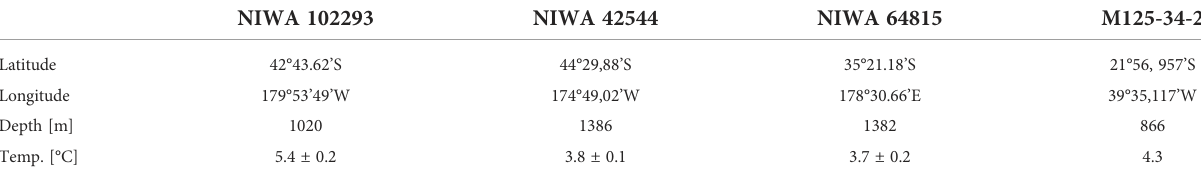
TABLE 1 Coordinates of the analyzed samples in the Paci fi c (NIWA 102293; NIWA 42544; NIWA 64815) and the gravity core (M125-34-2) in the South Atlantic.